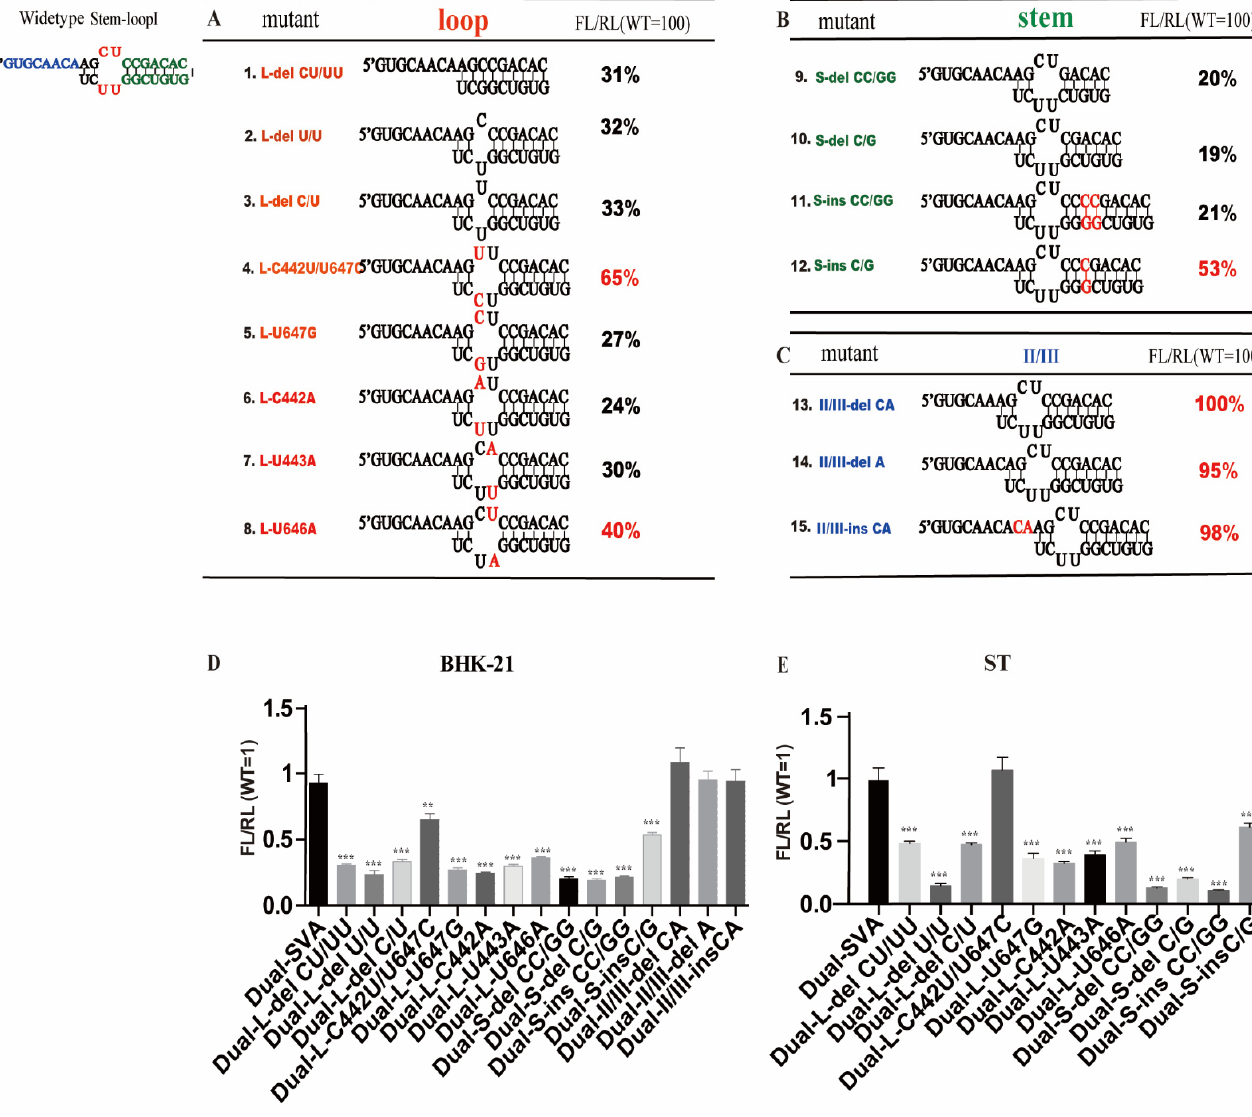
Figure 4. Mutational analysis of stem loop I. IRES activity with mutations in stem ( A ), loop ( B ) and inter-domain II/III region ( C ) IRES activity assay focused on the stem-loop I by mutations for further analyses. Monolayers of BHK-21 were transfected with in vitro-transcribed RNA of luciferase replicons and incubated at 37 °C. The activities of luciferase (Rluc) and Firefly luciferase (Fluc) were measured at 12 h post-transfection in BHK-21 ( D ) and ST cells ( E ). Data are means +SD from three experiments. Significance of the changes were analyzed by Student’s t-test and indicated by *** p < 0.001, ** p < 0.01.